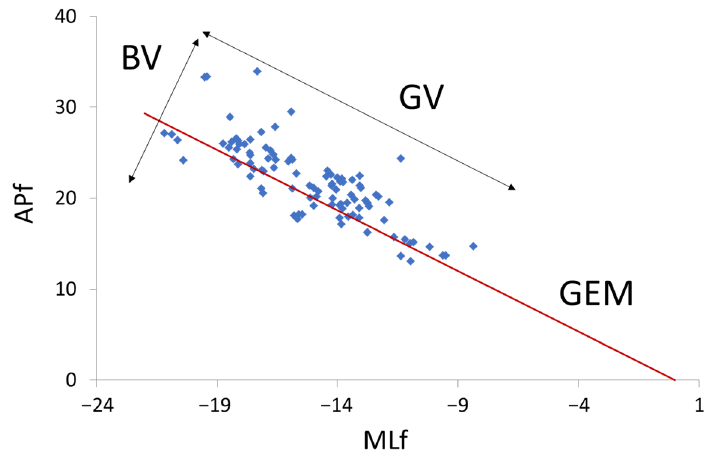
Figure 3. Representation of the different motor synergies variability. GV: Good variability; BV: Bad variability; MLf: force in medial–lateral axis; APf: force in anterior–posterior axis.